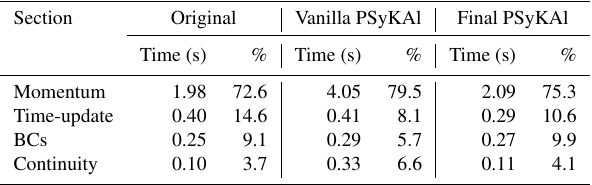
Table 3. The performance profile of the original and PSyKAl ver- sions of NEMOLite2D on the Intel Ivy Bridge CPU (for 2000 time steps of the 128 2 domain and the Intel